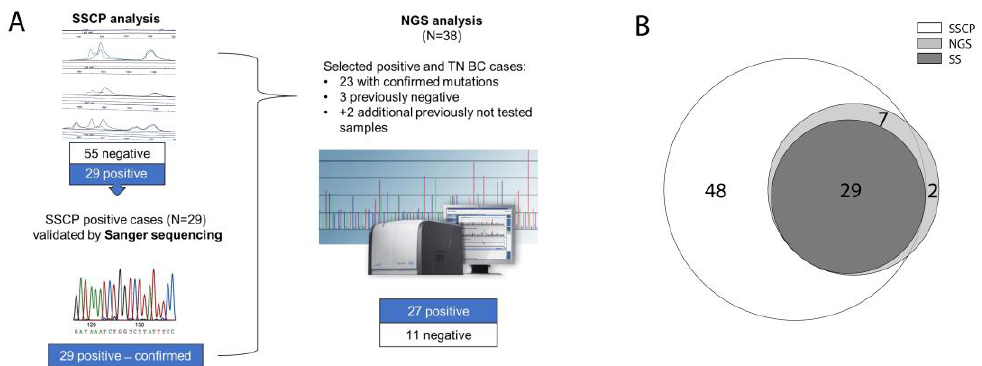
Figure 2. The schematic view of TP53 sequencing analysis: the workflow ( A ), and Venn diagram depicting samples overlapping between different methodologies for mutation detection ( B ); NGS — next-generation sequencing; SS — Sanger sequencing; SSCP — single-strand conformation polymorphism.